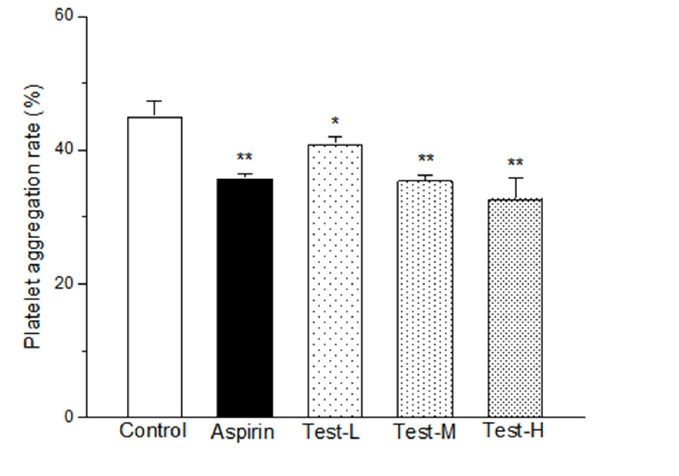
Figure 4. 1 H NMR ( a ), 13 C NMR ( b ), HSQC ( c ) and COSY ( d ) spectra of AAP-b2.